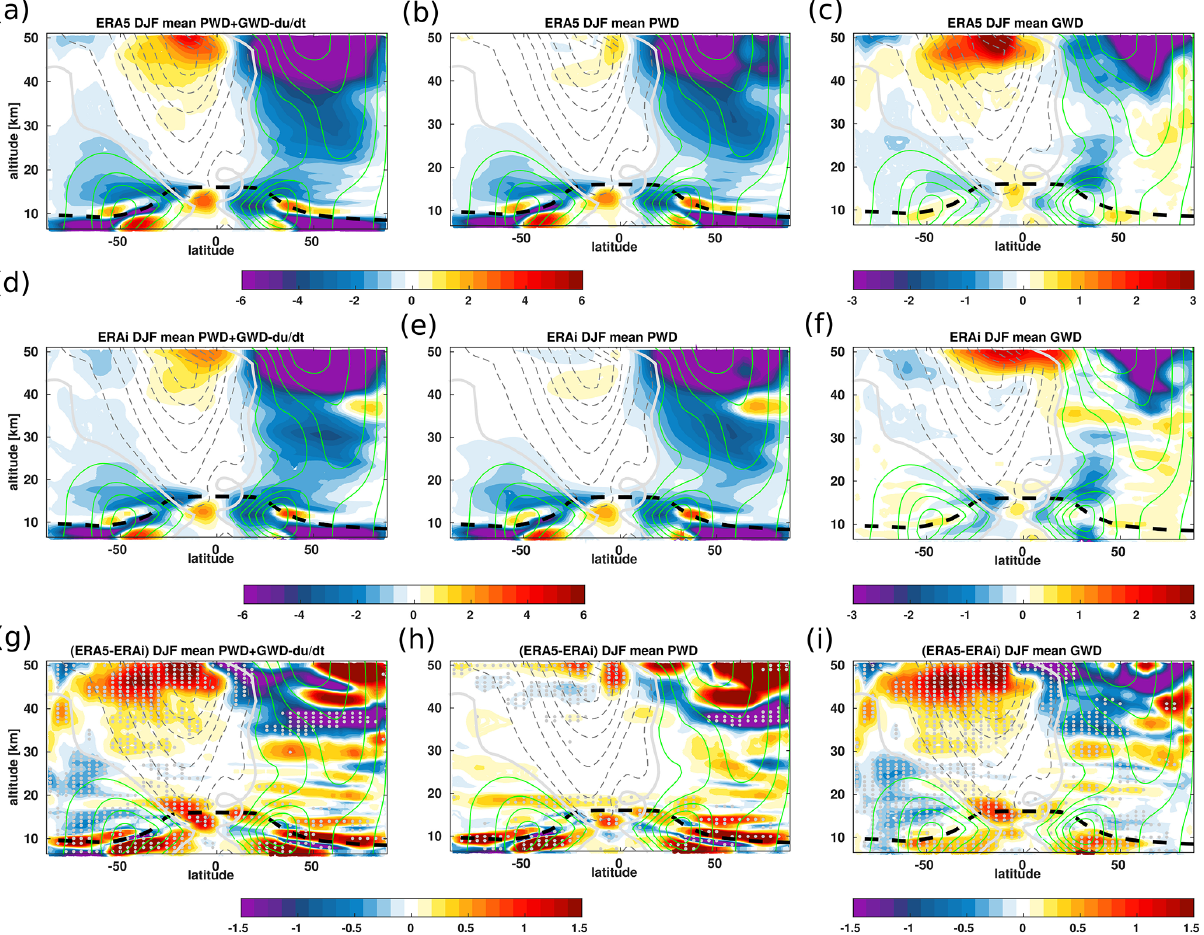
Figure A1. Zonal mean distribution of the winter seasonal mean (DJF) net wave forcing (planetary wave drag + gravity wave drag − d u/ d t ) (a, d) , planetary wave drag (b, e) , and gravity wave drag (c, f) together with the associated differences (g–i) between the ERA5 (a–c) and ERA-Interim (d–f) reanalyses for the 1979–2018 time period. The unit of the wave drag is in ms − 1 d − 1 . Grey dots in pan- els (g–i) indicate regions where the differences between the ERA5 and ERA-Interim reanalyses are statistically significant at 95% estimated using Student’s t test. The climatological tropopause from the ERA-Interim is indicated as the dashed black horizontal line. The thick white line indicates the zero-line zonal mean wind. The thin green and grey lines indicate the climatological zonal mean